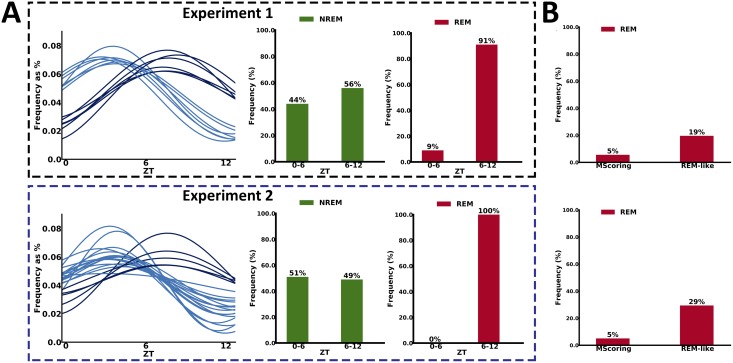
Temporal profile of REM-like states.(A) Analysis of the peaks during the light phase (07:00–19:00) identified 2 populations of latent states, presenting peaks either in the first or the second half of the subjective night. Top graphs are associated with the first experiment (data coming from the 3 wild-type genetic backgrounds). Bottom graphs are associated with the second experiment (Zfhx3Sci/+ mutant strain versus Zfhx3+/+ littermate controls). In both experiments, the majority of the substages that map into the second half of the light phase has a high probability to be classified as REM (therefore REM-like). The substages classified as NREMs are equally divided into the first and second half of the light phase. (B) Comparison between manually annotated REMs versus REM-like states generated by our approach, which peak in the second half of the light phase, in the 2 experiments. Graph shows the percentage of epochs labeled as REM (refer also to S1 Data). NREM, non-rapid eye movement; REM, rapid eye movement; ZT, zeitgeber time.